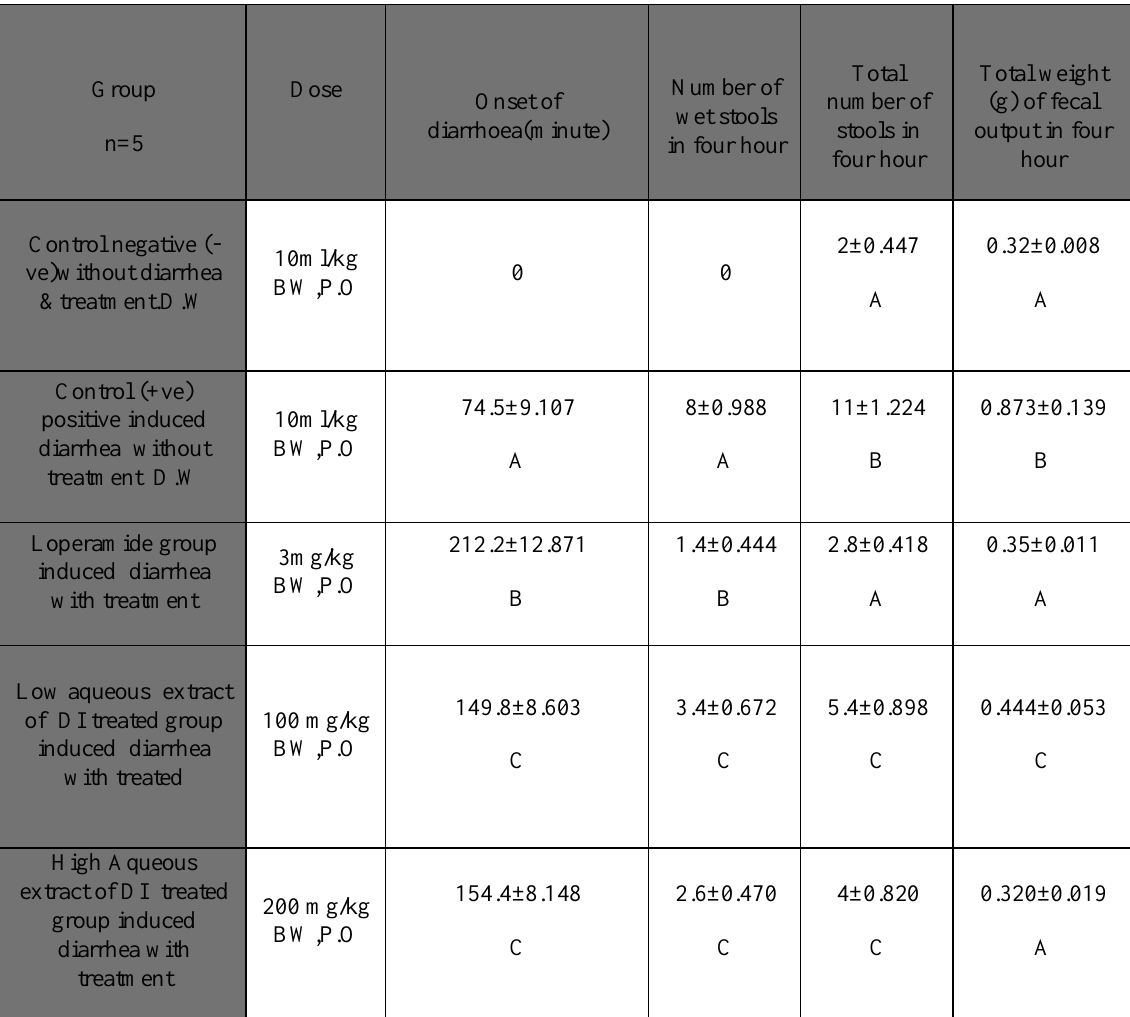
Table(1).Effect of Aqueous extract of datura innoxia and other treatment on castor oil induce diarrhea in